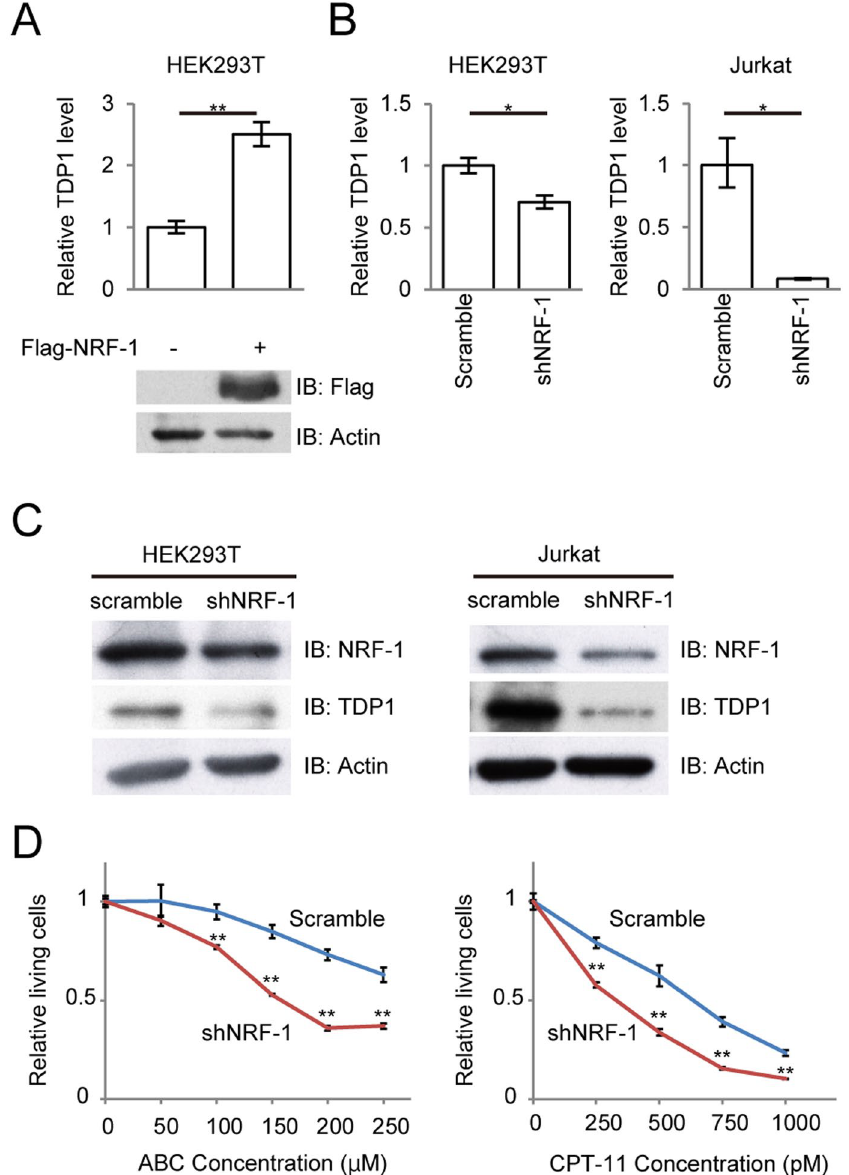
Figure 3. Functional analysis of the effect of NRF-1 on the expression level of TDP1. ( A ) Quantitative comparison of TDP1 mRNA levels between NRF-1 ectopic expression and negative-control cells in HEK293T cells by real-time PCR. Transfectants were harvested 36 h after transfection of lentivirus vector expressing Flag-NRF-1. Data shown are the mean ± SD ( n = 3). ( B ) and ( C ) Transfection of lentivirus vector expressing shNRF-1 decreases the expression of TDP1 mRNA and protein in HEK293T cells and Jurkat T cells. The transfectants were harvested 5 days after transfection. Data shown are the mean ± SD ( n = 3). ( D ) Viability of the shNRF-1 transfected Jurkat T cells after 48 h treatment with the indicated concentration of ABC or CPT-11. MTS values of treated cells relative to untreated cells are shown. Data shown are the mean ± SD ( n =